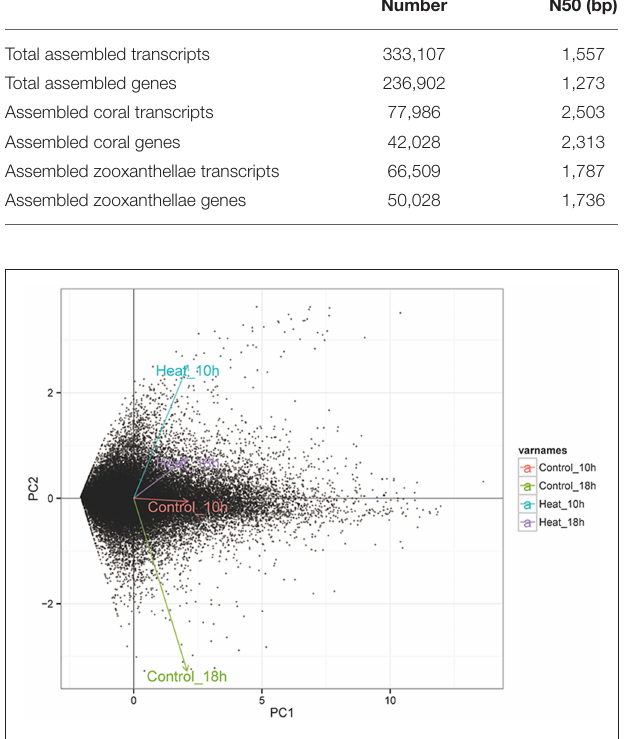
FIGURE 2 | The PCA analysis of the expression level of all genes in four transcriptome groups (Control_10h, Heat_10h, Control_18h, and Heat_18h) of coral G. fascicularis after heat stress.